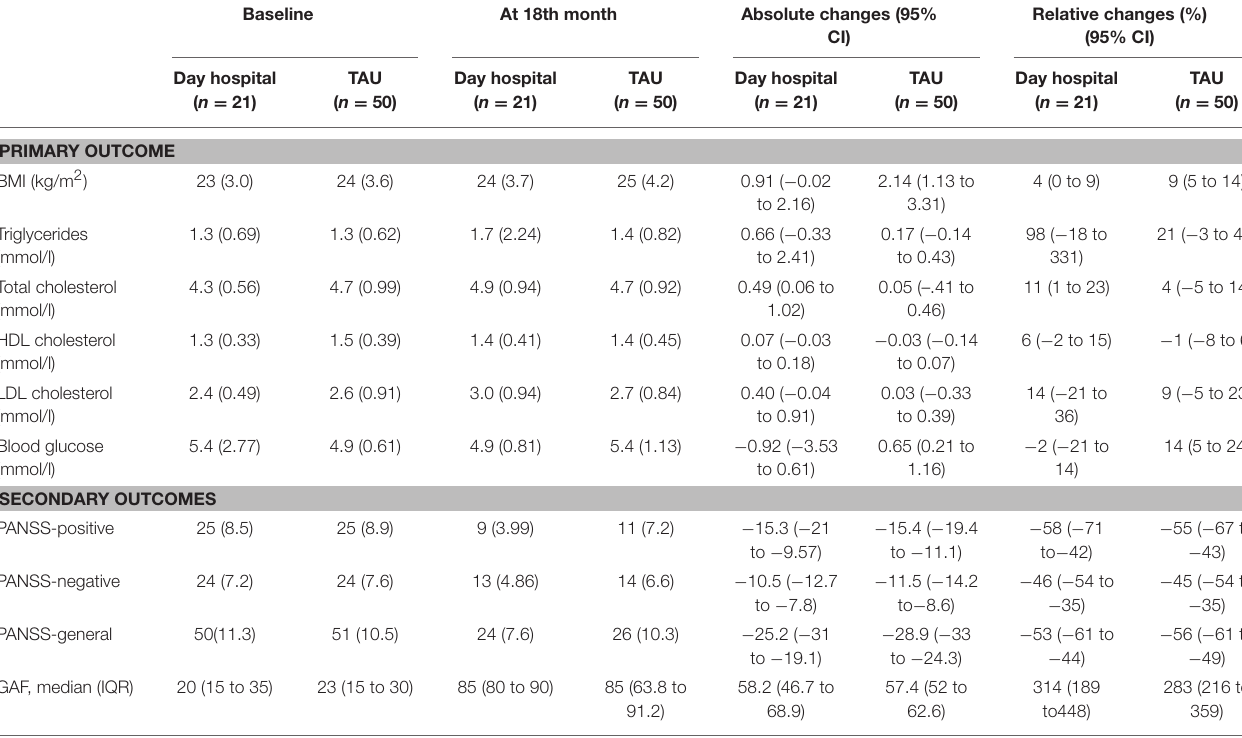
TABLE 2 | Changes of the primary and secondary outcomes according to the treatment group during the 18 months follow up.